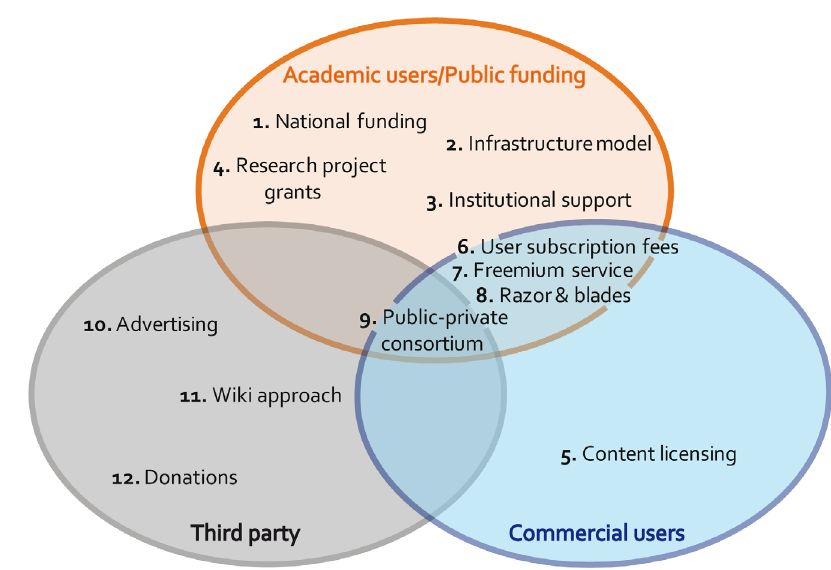
Figure 1. Funding models sources. The 12 considered models are represented depending on the origin of the